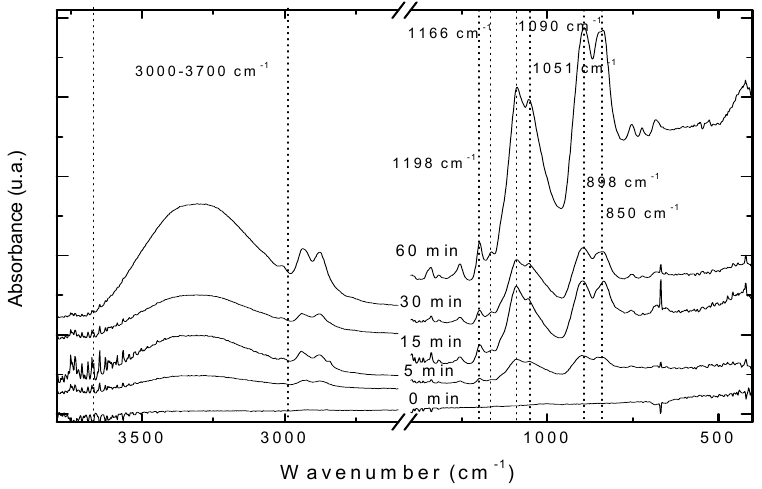
Figure 9. FTIR of the film produced on aluminum specimen silanized with 3% GPTMS at different times.